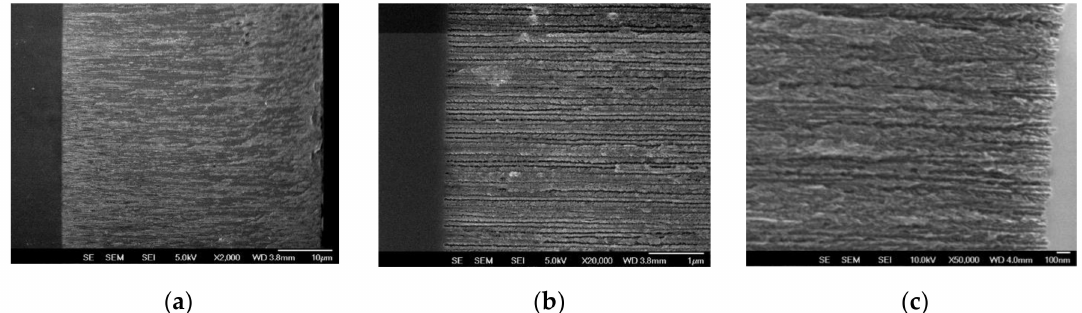
Figure 1. ( a ) Cross section of a PSi-A sample: porosity is homogeneous along the entire pore depth. ( b ) Higher magnification of the bottom part of PSi-A layer. ( c ) Cross section of PSi-B sample.